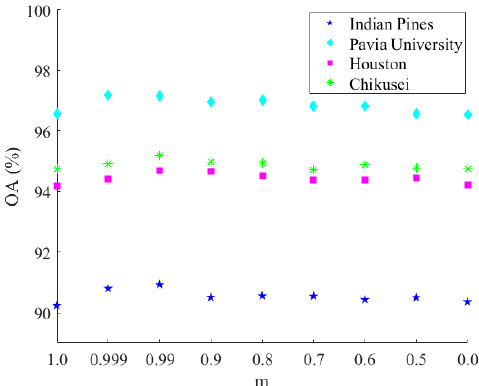
Figure 21. The overall accuracy of SCL with different values of momentum coefficient 𝑚 .